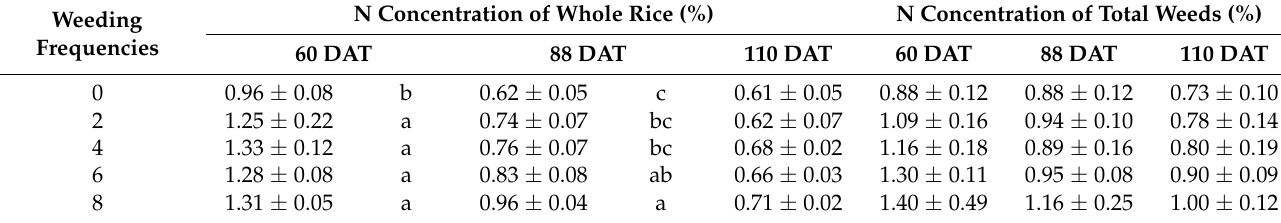
Table 1. Effects of weeding frequencies on nitrogen concentrations of rice and total weeds at 60, 88, and 110 DAT (days after transplantation). Values are given as mean ± standard deviation. Value followed by different letters in each column are statistically different at p < 0.05 based on Tukey’s HSD test. 0, 2, 4, 6, and 8 was the frequency of mechanical weeding until 49 DAT.